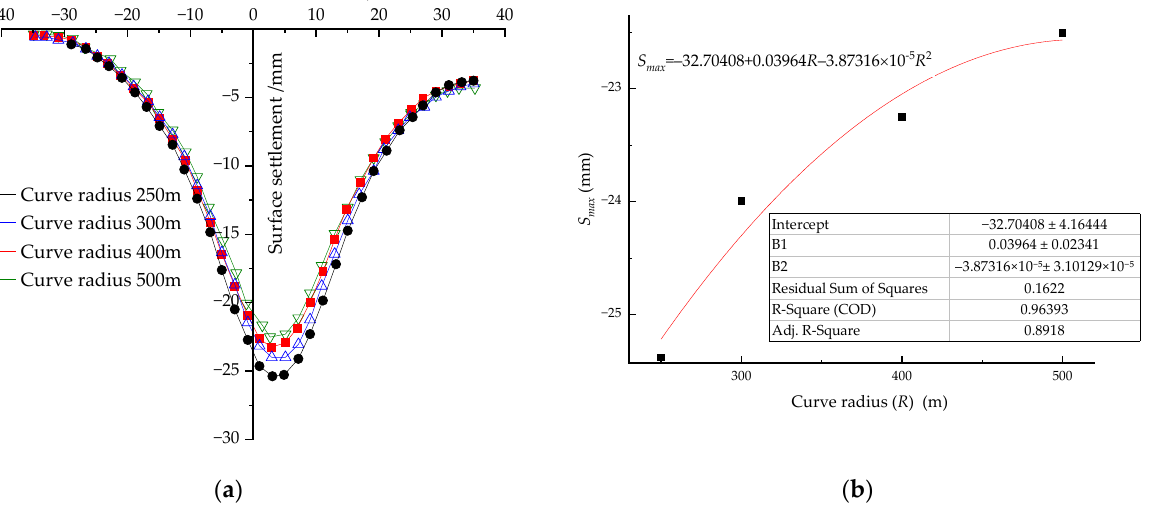
Figure 9. Surface settlement under various curvature radiuses: ( a ) curves of surface settlement; ( b ) maximum surface settlement with various curvature radiuses.